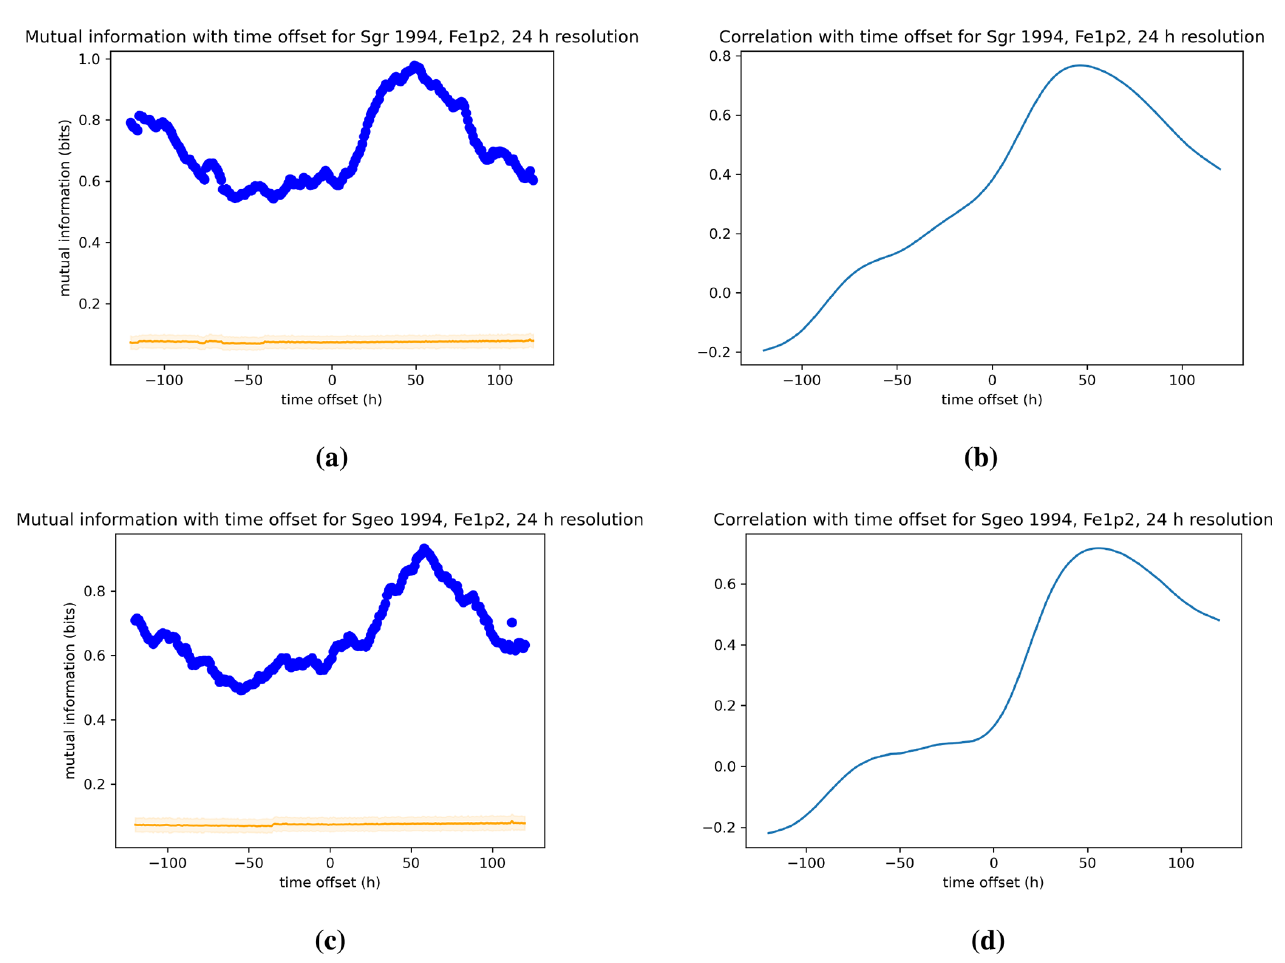
Figure 5. Same as in Fig. 4 but with a 24h moving average of each